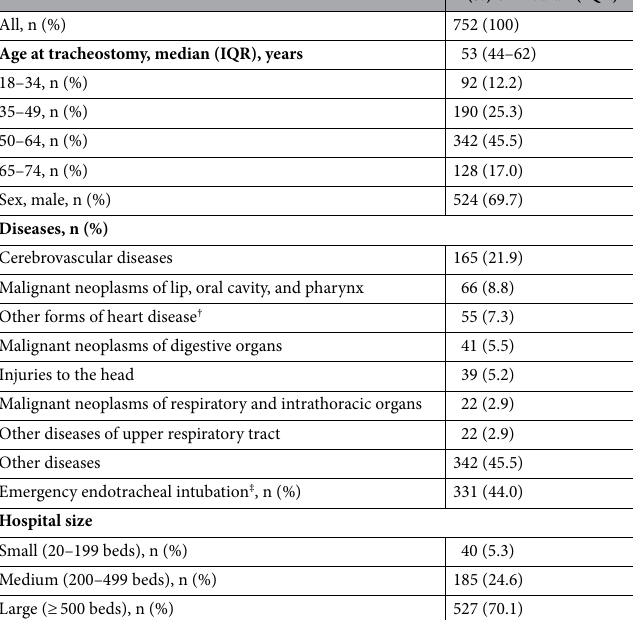
Table 1. Characteristics of patients who underwent tracheostomy. IQR interquartile range. † Cardiac arrest, heart failure, cardiomyopathy, acute and subacute endocarditis, other cardiac arrhythmias, nonrheumatic mitral valve disorders. ‡ Emergency unscheduled endotracheal intubation for critical care, not including testing, anesthesia, or tube